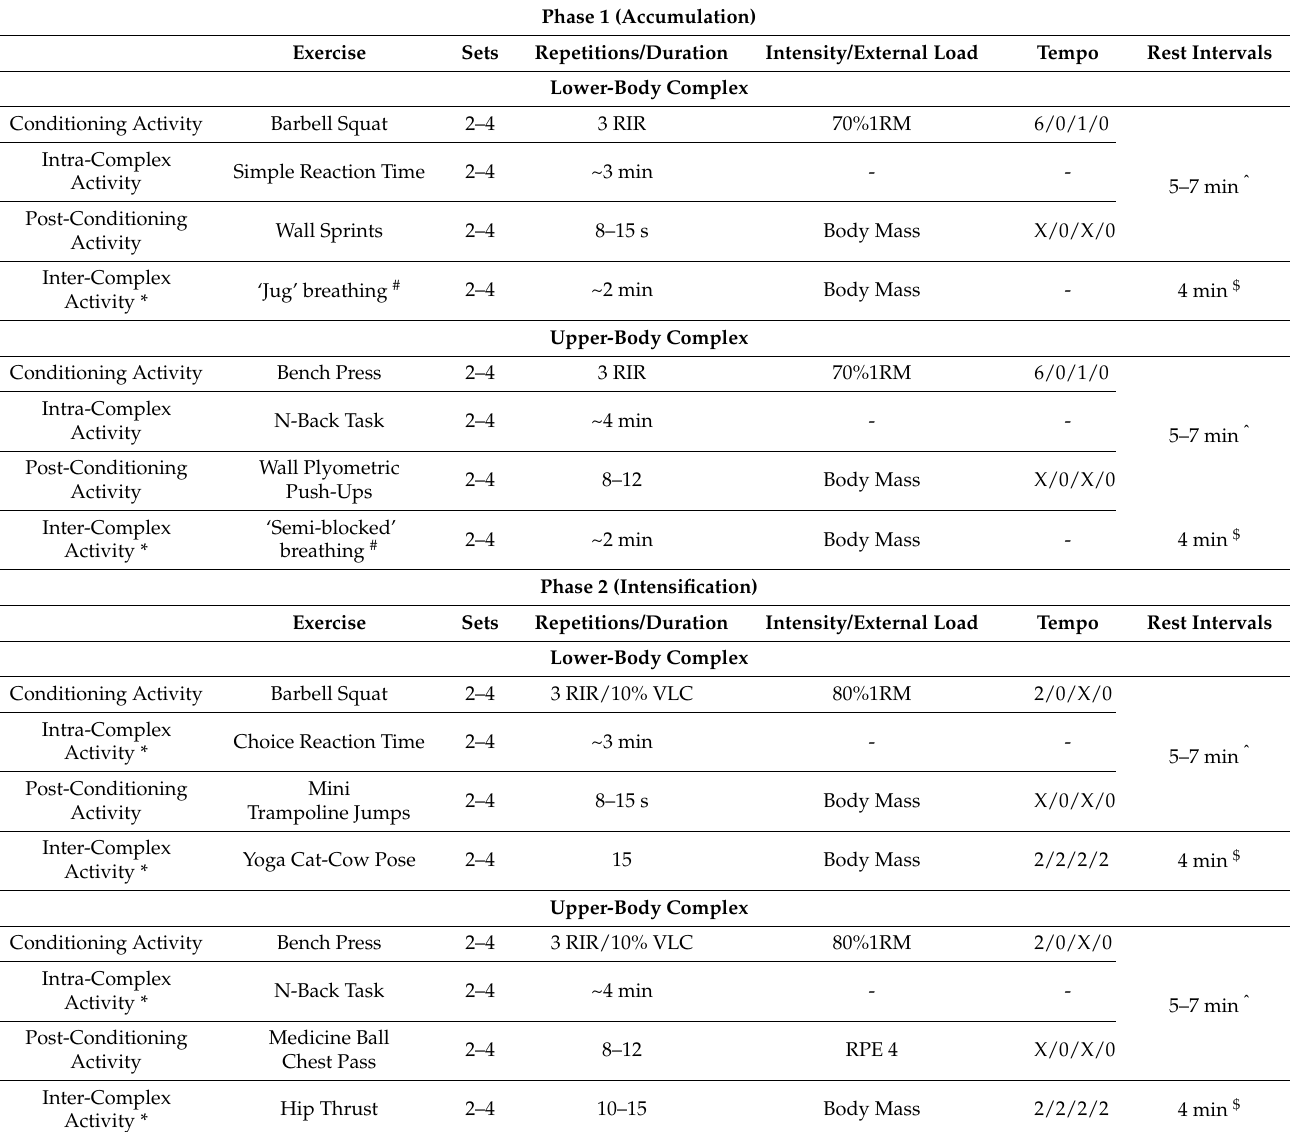
Table 1. The proposed model of complex training adapted for the